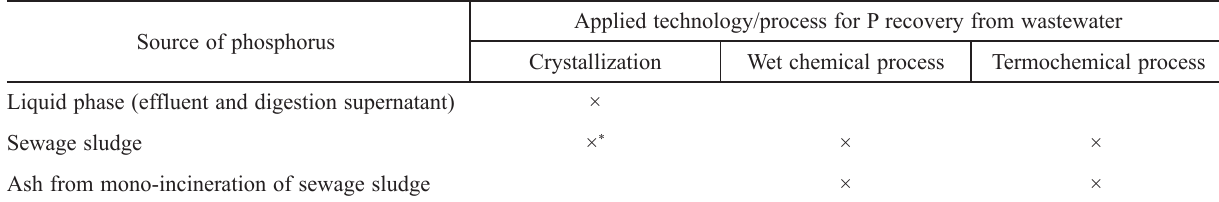
Table 2 – Use of different phosphorus recovery technologies depending on the source in the WWTPs Applied technology/process for P recovery from wastewater Source of phosphorus Crystallization Wet chemical process Termochemical process Liquid phase (effluent and digestion supernatant) × Sewage sludge × * × × Ash from mono-incineration of sewage sludge × × * Crystallization and precipitation of P from the liquid phase after wet chemical treatment of sewage